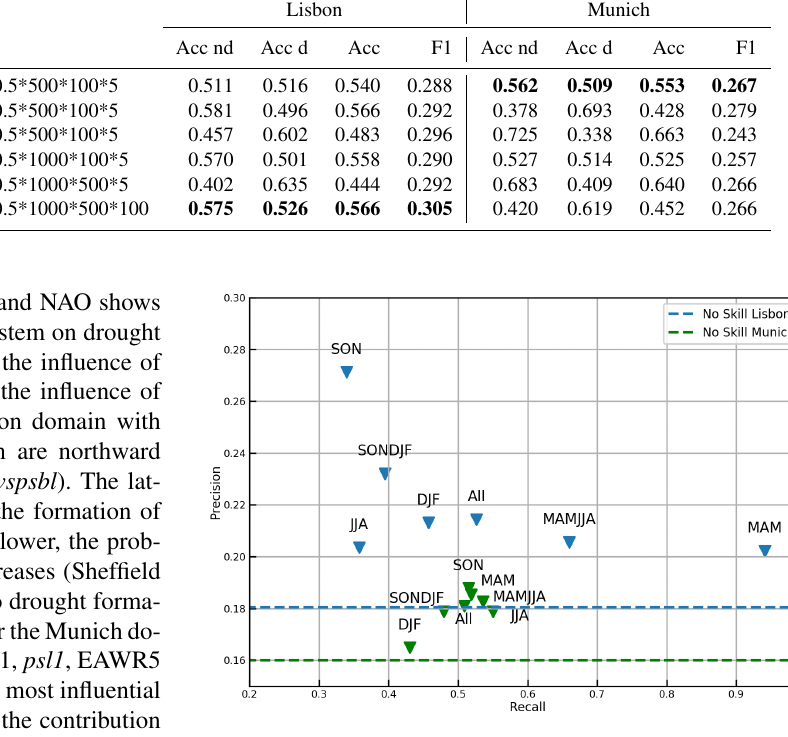
Figure 6. The effect of seasonality on precision and recall for Lis- bon (blue) and Munich (green). The results indicate that for the Mu- nich and Lisbon domain better drought predictability is possible in spring, fall and